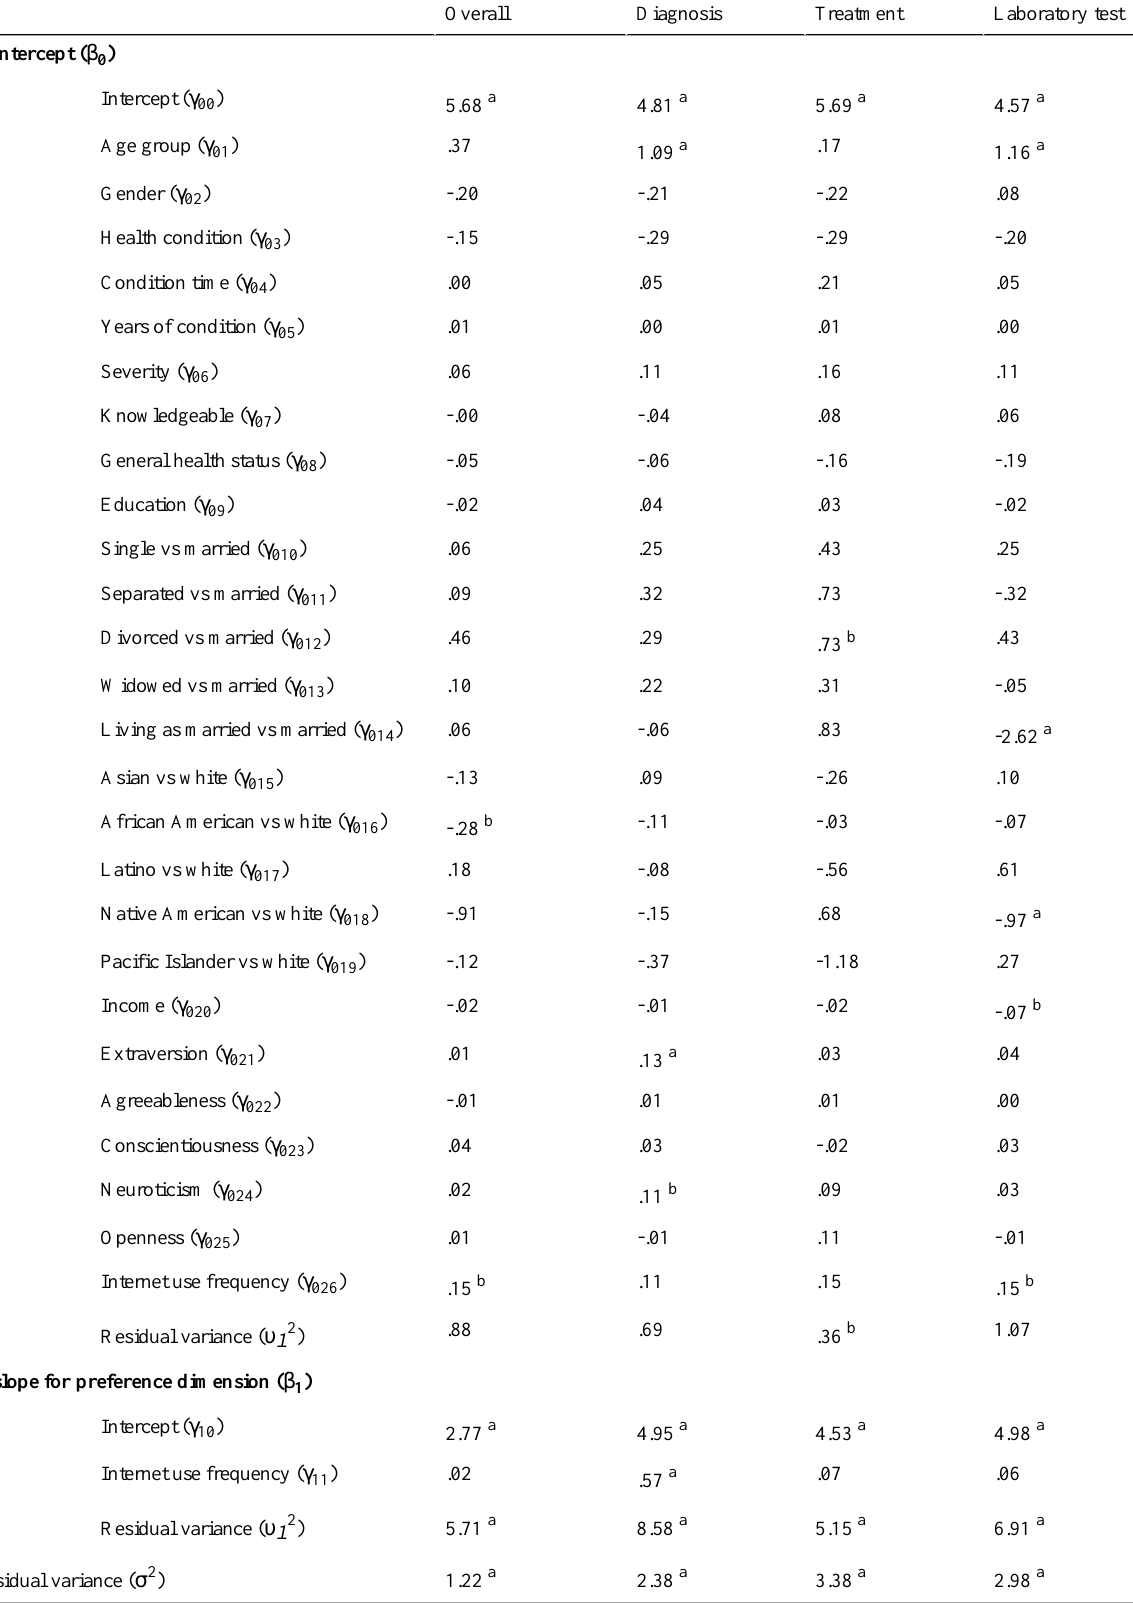
Table 2. Multilevel modeling results – overall, diagnosis, treatment, and laboratory test (Level 2 [ie, between-person level] N=438; Level 1 [ie, within-person level] N=876; unstandardized coefficients are